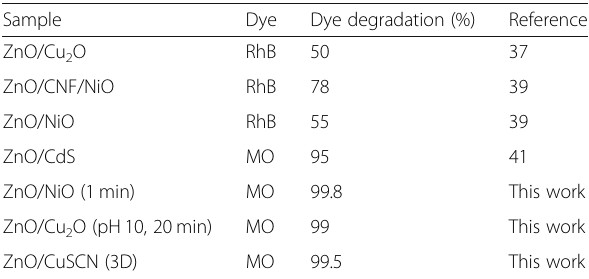
Table 2 The degradation rate in the same time (40 min) under the action of different